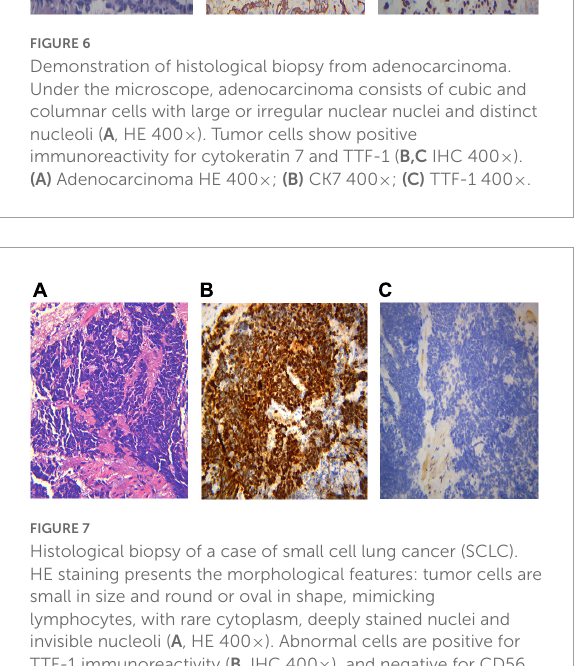
FIGURE5 An example of histological biopsy from a poorly differentiated squamous cell carcinoma (SCC). (A) Shows typical poorly differentiated morphological features of SCC. The tumor cells are large and flat, with fusiform deeply stained nuclei and abundant cytoplasm (HE 400 × ). The diagnosis is confirmed by the immunoreactivity for P40 ( B , IHC 400 × ) and P63 expression ( C , IHC 400 × ). (A) Poorly differentiated SCC (HE 400 × ); (B) P40 400 × ; (C) P63 400 × .